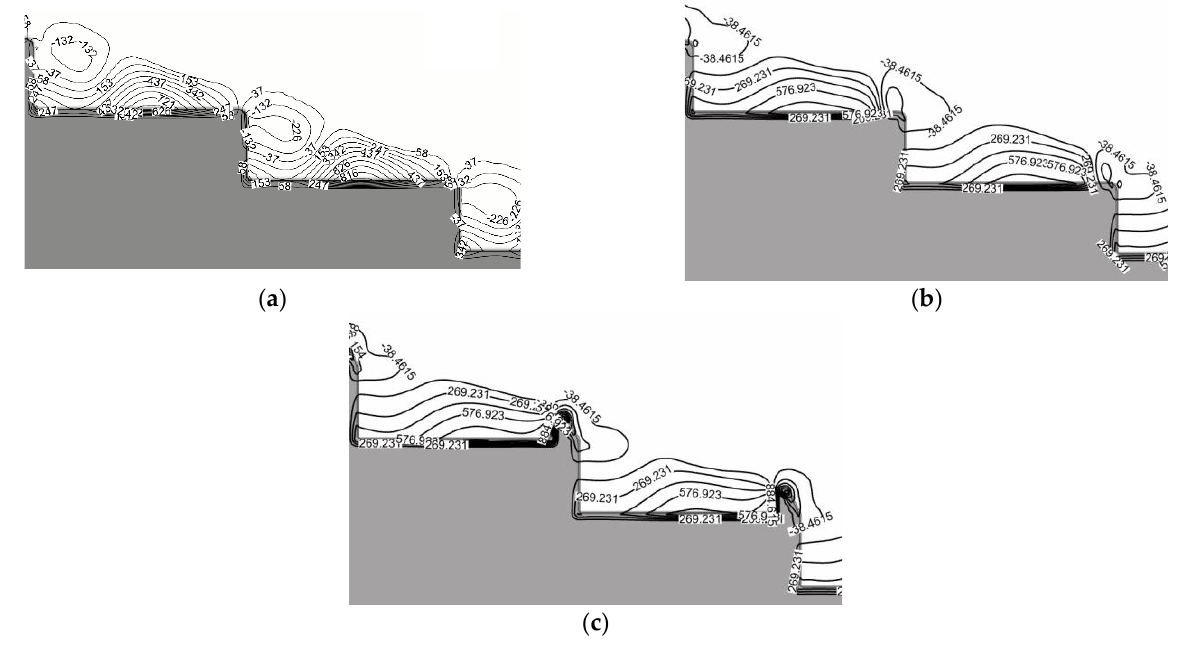
Figure 10. Cloud diagram of the pressure distribution on the step surface of different types: ( a ) Type I, y = 0.1 m; ( b ) Type II, y = 0.1 m; ( c ) Type II, y = 0.075 m.